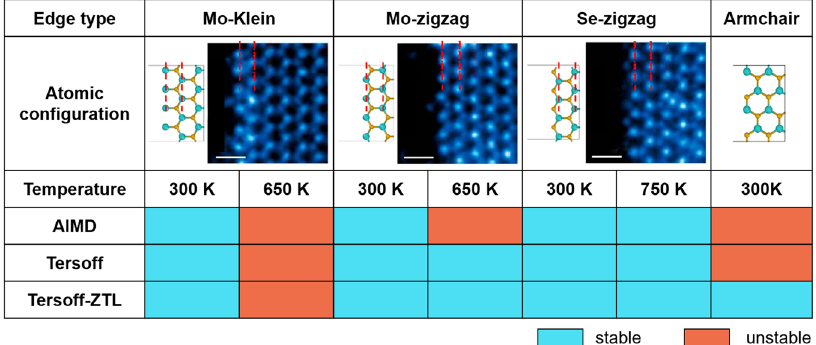
Fig. 5 Transferability test for the parametrized potentials (Tersoff and Tersoff-ZTL) on edge stability of monolayer MoSe 2 . The edges were observed in nanoporous MoS 2 fi lms grown with molecular beam epitaxy under high Mo fl ux 42 . Scanning transmission electron microscopy images of the corresponding edge structures for MoS 2 were retrieved from Zhao et al. 42 and are shown herein. Red dashed lines highlight the Mo atomic layers, and the scale bars represent 0.5 nm. The same edge con fi guration was equilibrated with ab initio MD (AIMD; for 1 ps) and MD (500 ps) at the speci fi ed temperature. An “ unstable ” con fi guration is de fi ned as a con fi guration that undergoes breakage and reformation of chemical bonds during equilibration (see Supplementary Videos 2 – 5 for the movies of those simulations). We note a longer simulation time for MD to reveal the unstable edge con fi gurations due to limitations of interatomic potentials to re fl ect electronic interactions embedded in the AIMD simulations. In the atomic snapshots, Mo atoms are colored cyan, and Se atoms are colored orange. The Tersoff-ZTL corresponds to the parameterized potential with the training data of “ Tersoff ” plus the three acoustic phonon modes, i.e., ZA, LA, and TA. Reprinted (adapted) with permission from Zhao et al. 42 Copyright (2018) American Chemical